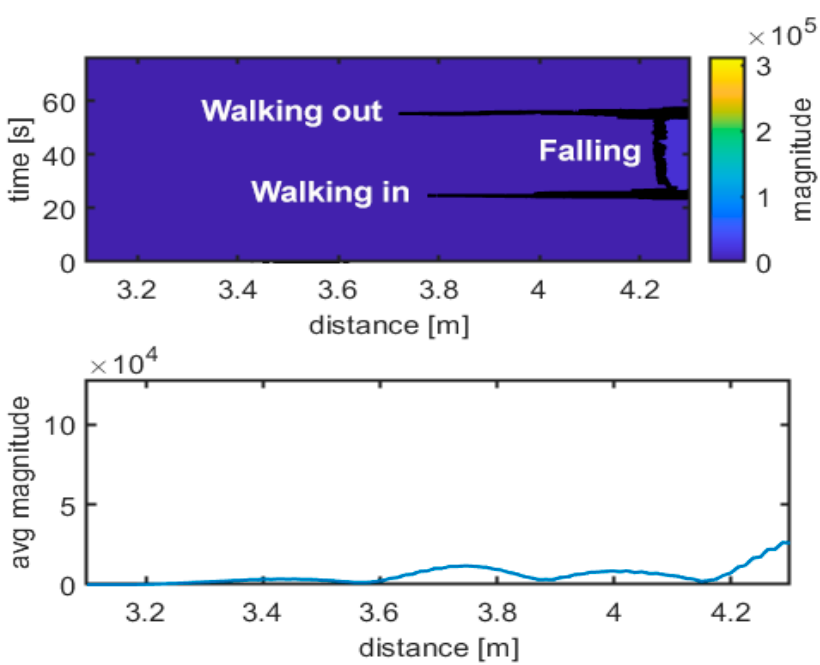
Figure 9. Movement identification. Experimental results: walking in–falling–walking out. Magnitude unit is µV.